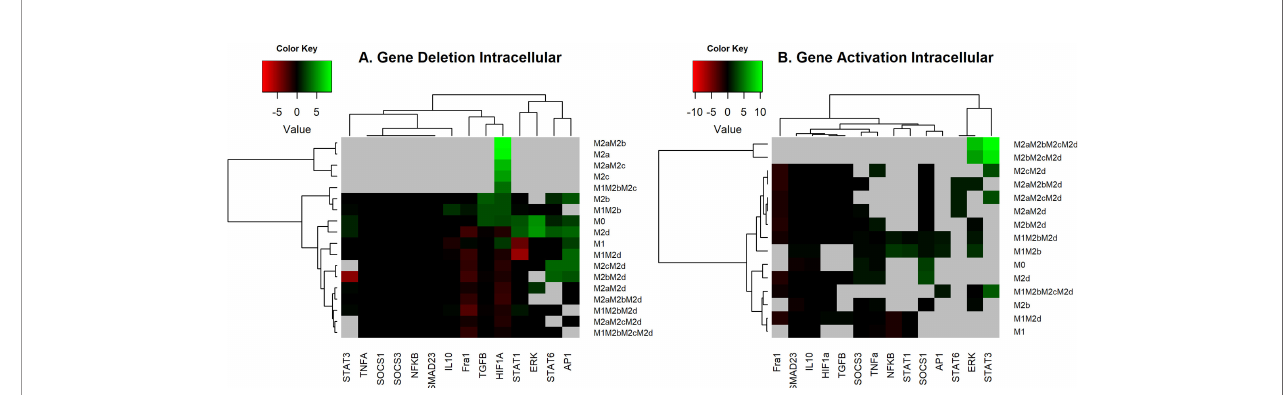
FIGURE 3 | Heat Map of the overexpression and knock-out of transcriptional factors. (A) Heat Map of the overexpression of transcriptional factors of macrophage polarization. We maintained the expression of the node as 1, simulated, and reviewed the attractors obtained. All overexpression was compared with the wild-type (original network) with log2 fold change. (B) Heat Map of Knock-outs of transcriptional factors of macrophage polarization. The nodes were permanently fi xed with a value of 0; the perturbations were realized one by one until the attractors were reached. We compared the phenotypes of the wild-type with the perturbations by a log-fold change. Green and red regions indicate those attractors whose size of the basin of attraction increased or decreased after the perturbation. In black, we denote those attractors with few effects in the basin attraction size versus WT and after perturbation. Gray areas indicate those attractors that exist in the wild-type but do not remain